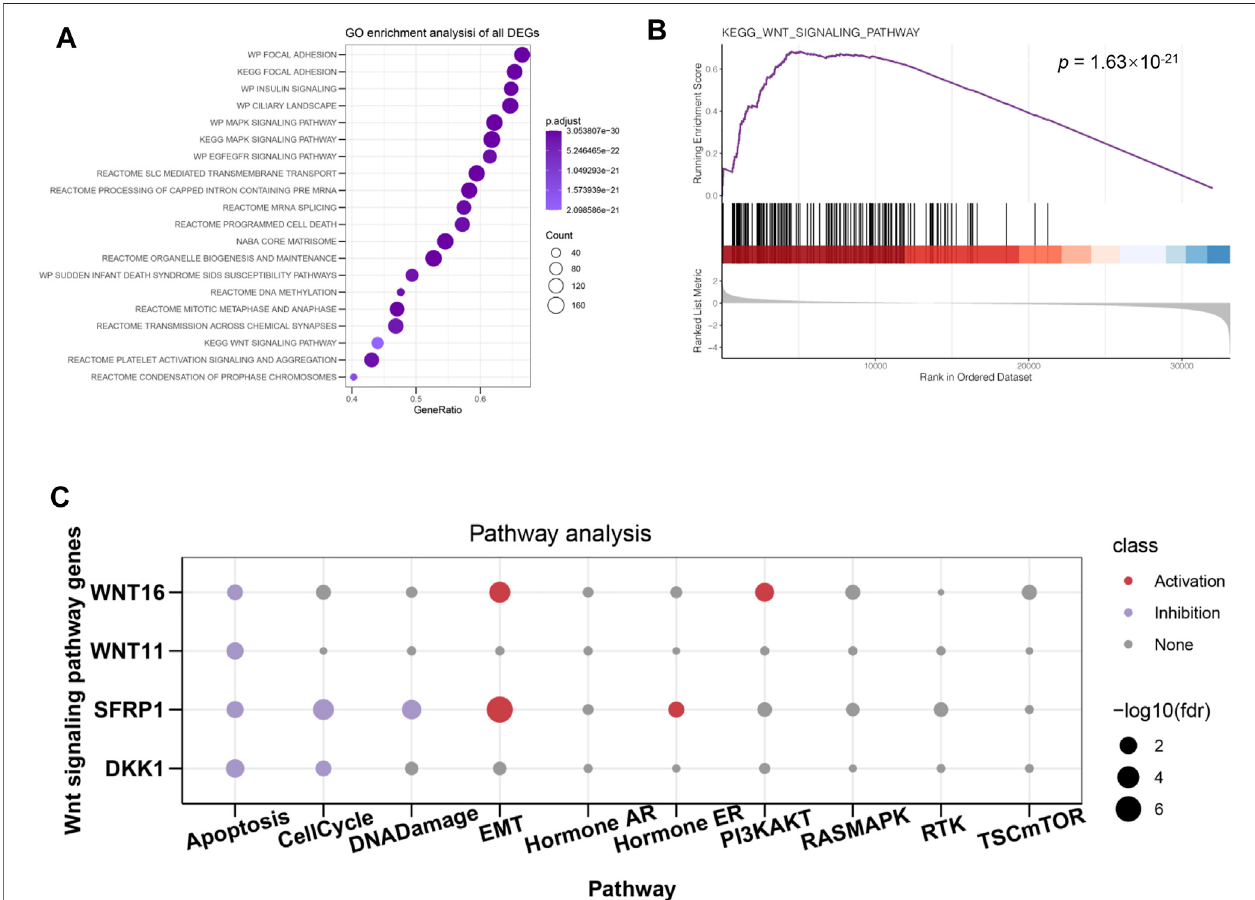
FIGURE 6 | DEGs between ATP6V1C2-high and -low group and the potential roles of identi fi ed DEGs. (A) GO and KEGG enrichment of DEGs; (B) Wnt signaling pathway enriched from identi fi ed DEGs; (C) The associations between Wnt hub genes and cellular processes/signaling pathways implicated in tumor progression. DEGs: differentially expressed genes; GO: Gene Ontology; KEGG: Kyoto Encyclopedia of Genes and Genomes; EMT: epithelial – mesenchymal